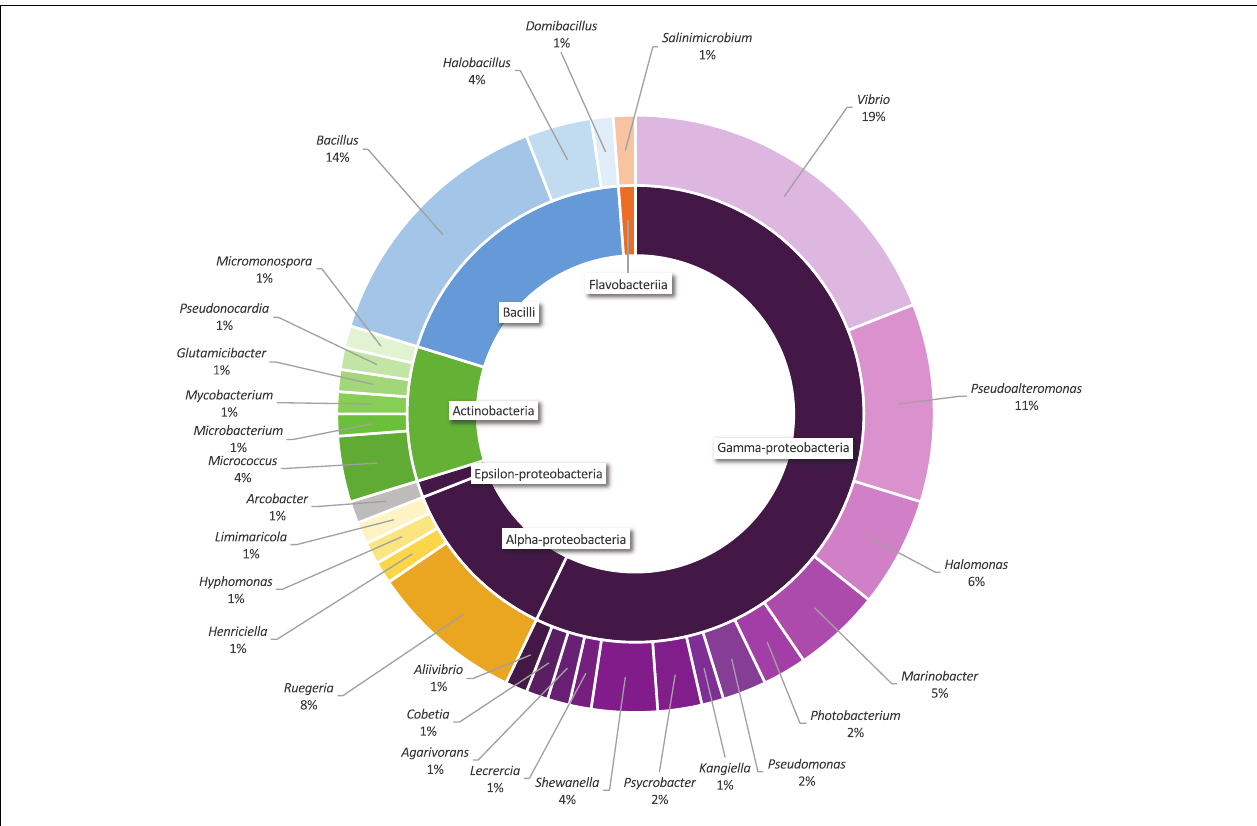
FIGURE 4 | Genera (external ring) and classes (internal ring) distribution of the marine bacterial collection isolated from volcano Tagoro.